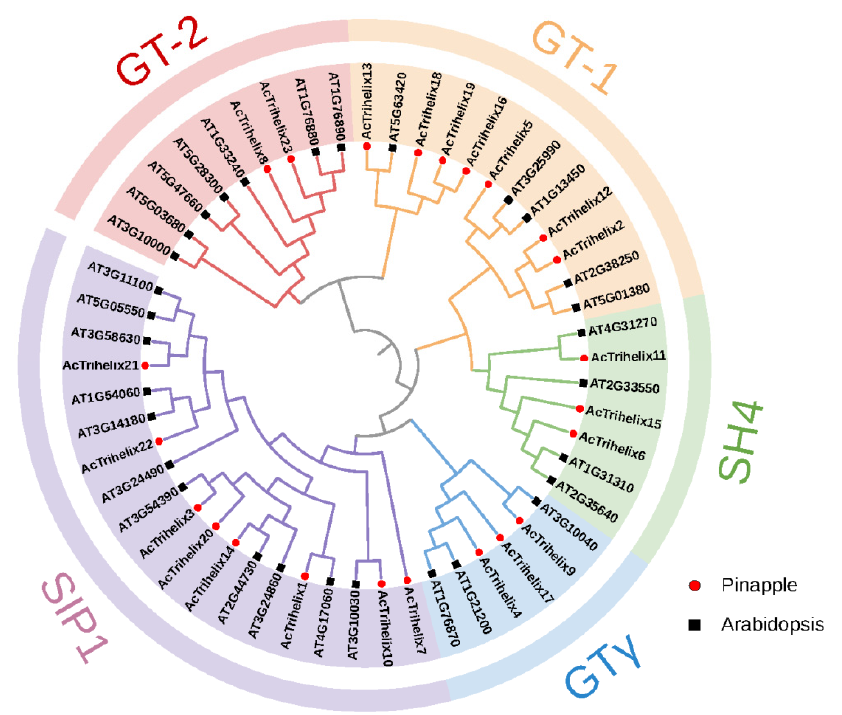
Figure 1. The phylogenetic analysis of Trihelix proteins between pineapple and Arabidopsis . The phylogenetic tree was made using MEGA 6.0 program. (neighbor ‐ joining method, bootstrap value = 1000).